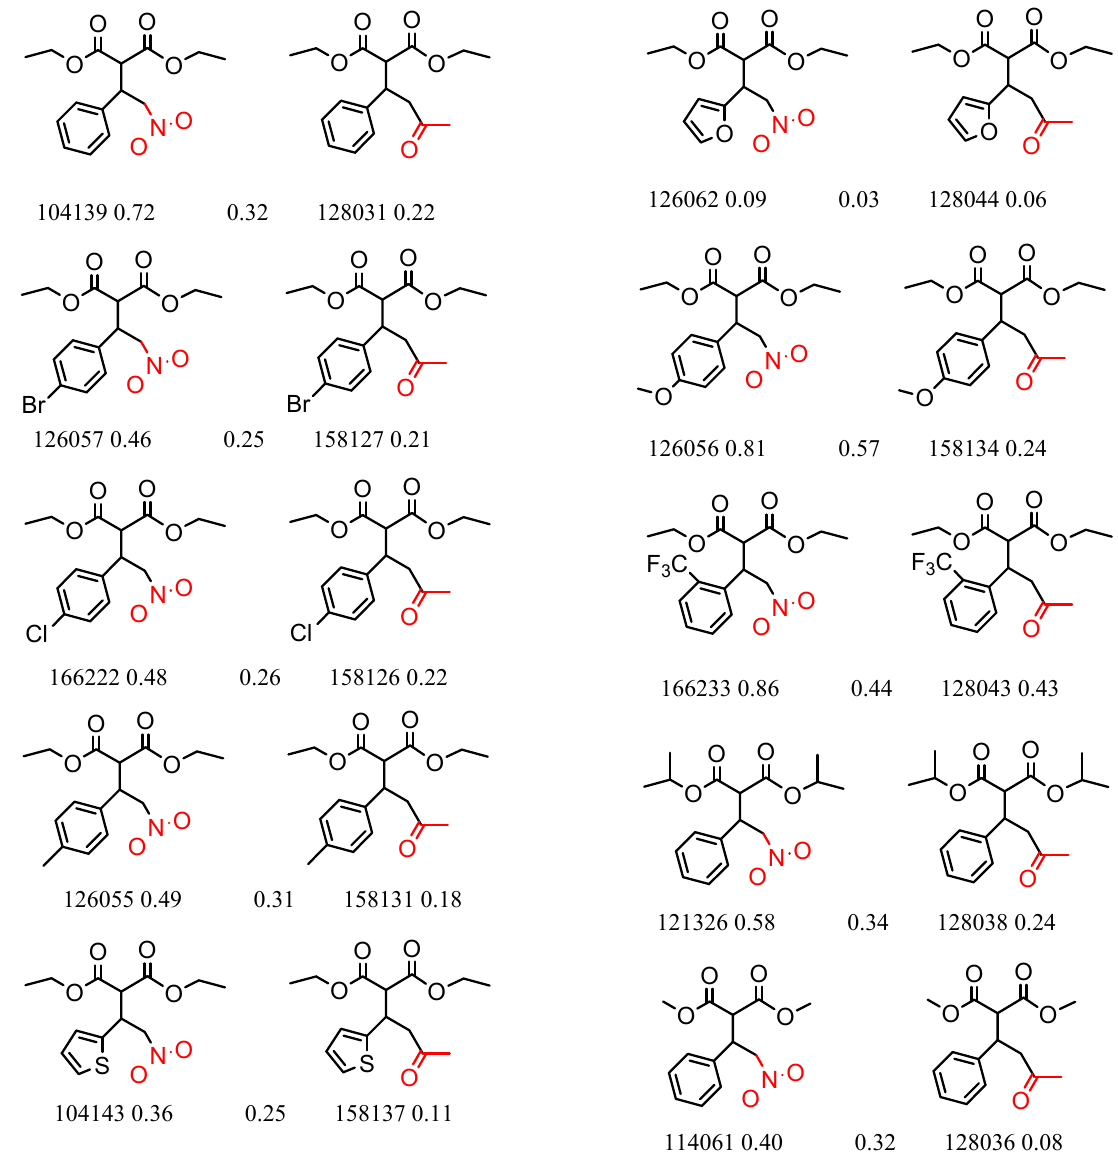
Figure 2. Expanded view of Cluster 2 for CSP_NO 23735 (Chiralpak-AD). There are 10 pairs in this cluster. Differences in structure are highlighted in red. Next to each compound is shown the Chirbase compound number and log( α ). The meanDiff within each pair is written between the molecules. This is an example of a cluster were the values of α can come from different references. See supporting information for conformational modeling showing differences in preferred conformations of nitro and methyl ketone analogs.